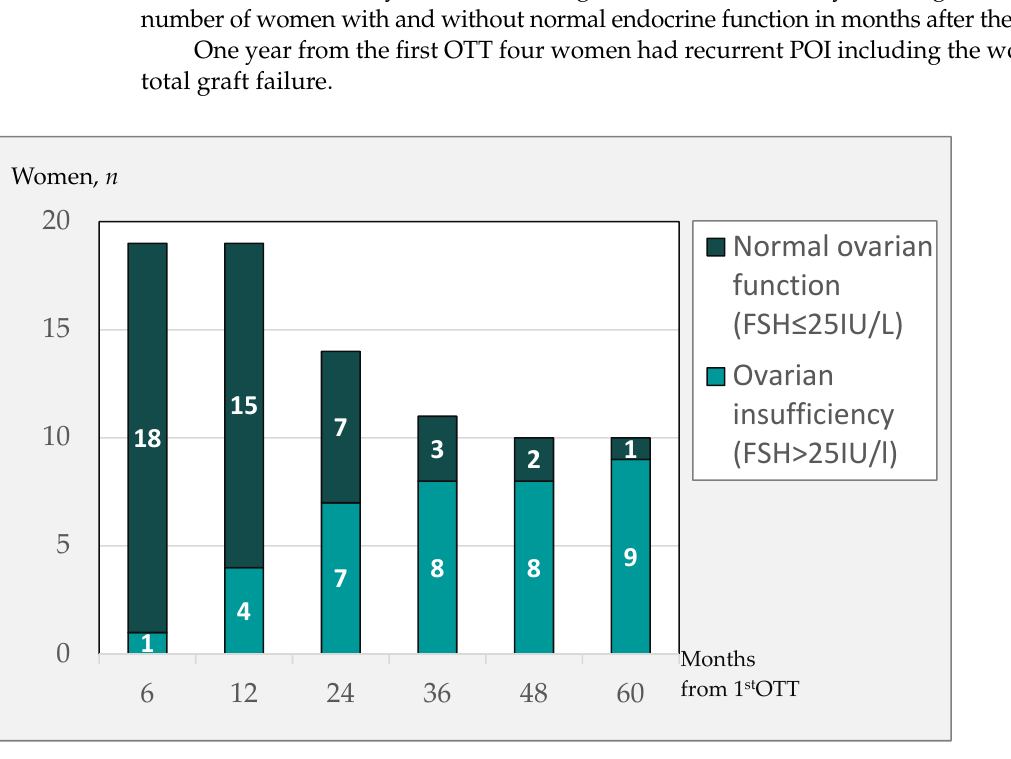
Figure 1. Endocrine function in women following the first OTT.